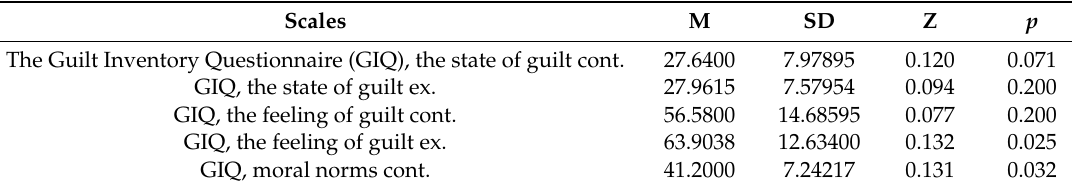
Table 1. Means, standard deviations, and the Kolmogorov–Smirnov statistic for each group compared for each variable. Scales M SD Z p The Guilt Inventory Questionnaire (GIQ), the state of guilt cont. GIQ, the state of guilt ex. GIQ, the feeling of guilt cont. GIQ, the feeling of guilt ex. GIQ, moral norms